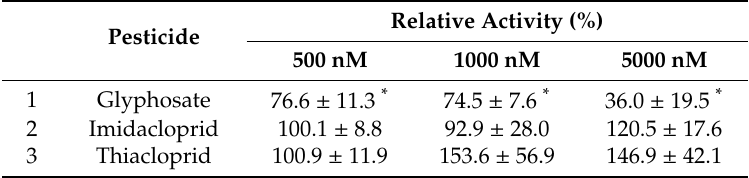
Table 1. Effect of pesticides on the aromatase activity. Table 1. E ff ect of pesticides on the aromatase activity.